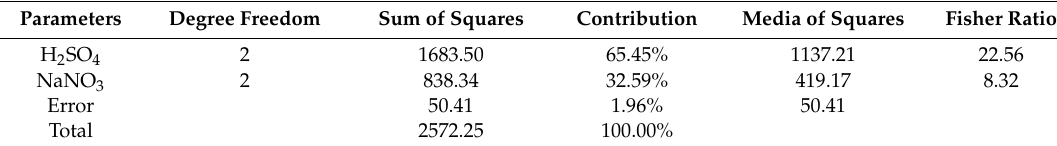
Table 6. Analysis of variance (ANOVA) for Cu extraction.